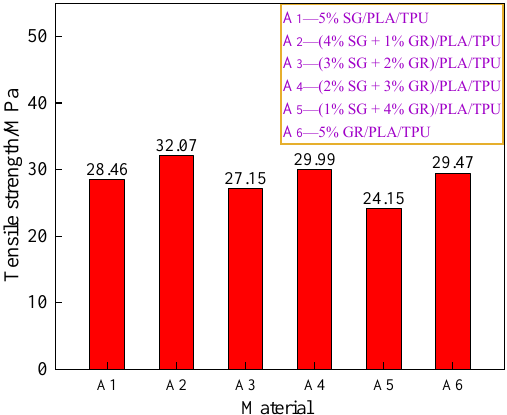
Figure 11. Tensile strength of A 1 ~A 6 composites .